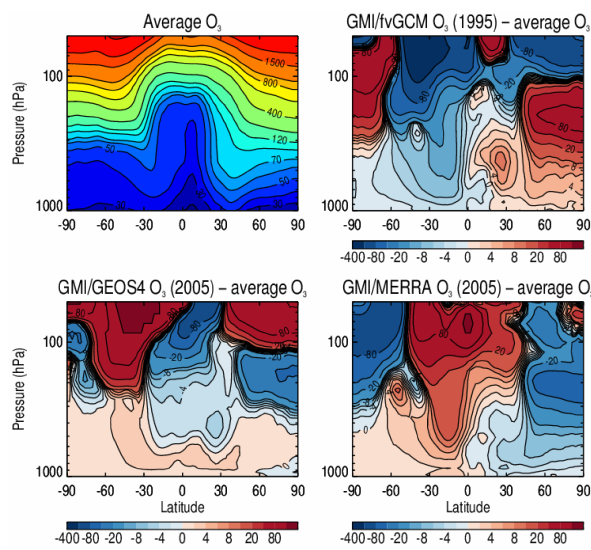
Figure 4. Same as Fig. 2 but for zonal mean ozone mixing ra- tios